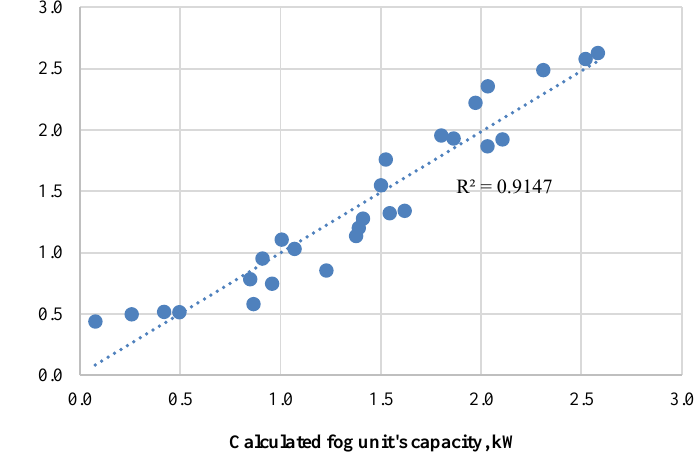
Fig. 5. Comparison of measured and calculated capacities of the fog